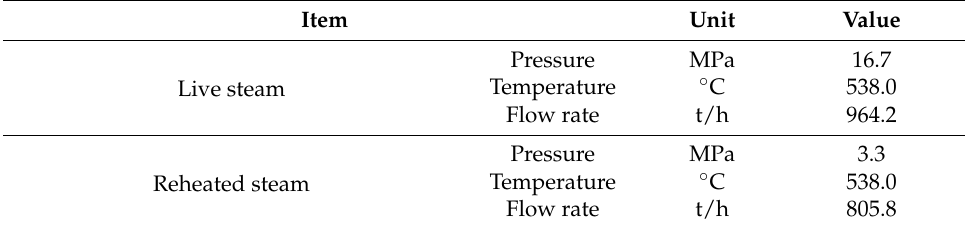
Figure 1. Diagram of the reference coal-fired HBP-CHP unit. Table 2. Basic parameters of the reference HBP-CHP unit under the rated heating condition.